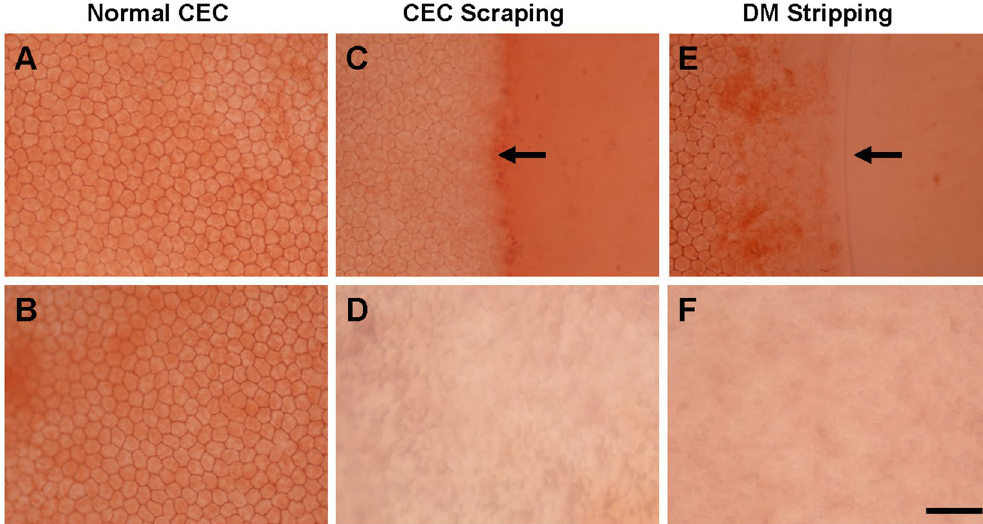
Figure 1. Alizarin red S staining of corneal endothelium. Alizarin red S staining showed endothelial cells in peripheral ( A ) and central ( B ) region of the normal rabbit cornea. In the CEC scraping group, cell damage border (arrow) could be seen just after the injury ( C ). Within the scraping area, there was no endothelial cell ( D ). In the DM stripping group, the cutting edge of the DM (arrow) was visible ( E ), and there was no endothelial cell inside the DM cutting edge ( E ) and the central cornea after DM stripping ( F ). Bar represents 100 μ